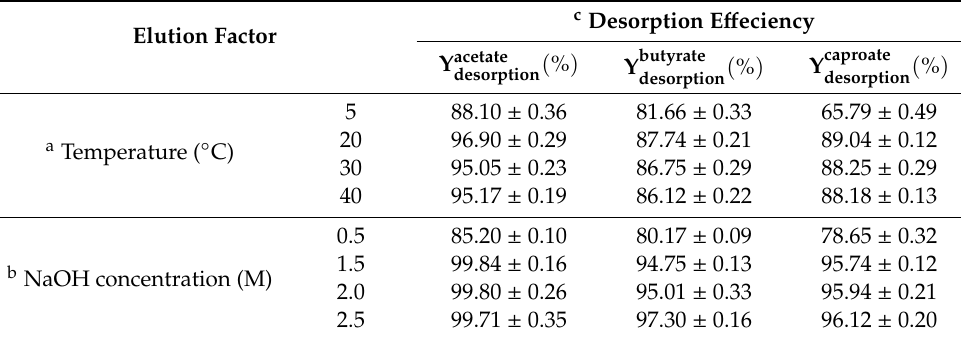
Table 2. The optimization of elution temperature and eluent concentration .